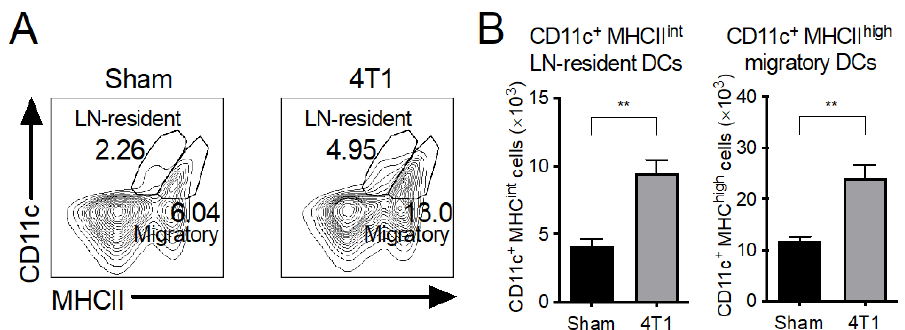
Figure 4. MLN DCs were increased in 4T1 tumor mice. At day 21 of transplantation into the right flank transplantation, mLNs from control (Sham) or tumor (4T1)-bearing mice were isolated. ( A ) Representative flow cytometry plots and ( B ) cell numbers of CD11c + MHCII int LN-resident DC and CD11c + MHCII hi migratory DC subsets. Numbers in plots indicate the corresponding percentage. Data are shown from a representative experiment from four independent experiments. The mean ± SEM and assessed with a Mann–Whitney U test. ** p < 0.01.